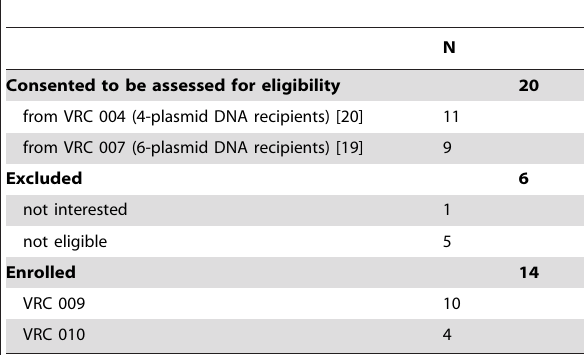
Table 1. Eligibility and enrollment